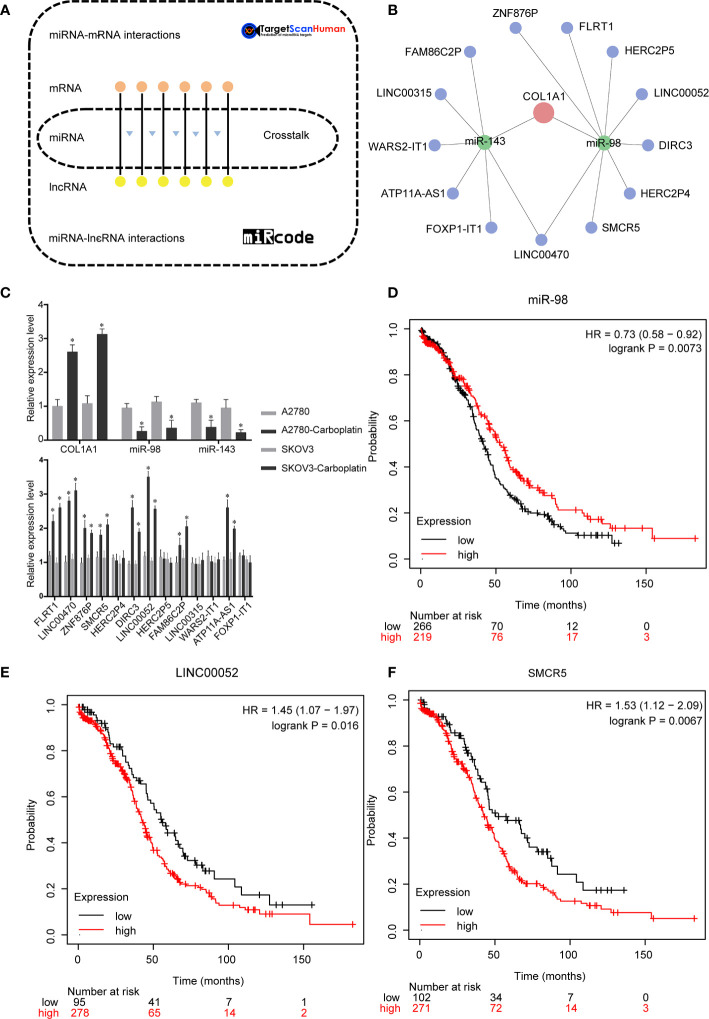
Upstream regulation mechanism of COL1A1 in carboplatin-resistant OV. (A) Bioinformatics methods were used to construct the ceRNA network of COL1A1. (B) ceRNA network of COL1A1. Red represents COL1A1, green represents miRNAs, blue represents lncRNAs. (C) Real-time PCR validation of candidates in ceRNA network. (mean ± SD, n =3). Asterisks indicate significant differences compared with the control group (*p < 0.05). Kaplan–Meier overall survival analyses for miR-98 (D), LINC00052 (E), and SMCR5 (F) in OV.